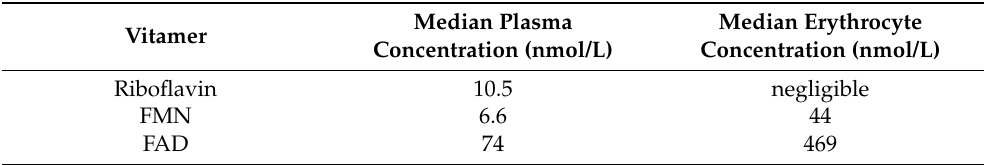
Table 7. Concentrations of B 2 vitamers in plasma and erythrocytes. Median Plasma Vitamer